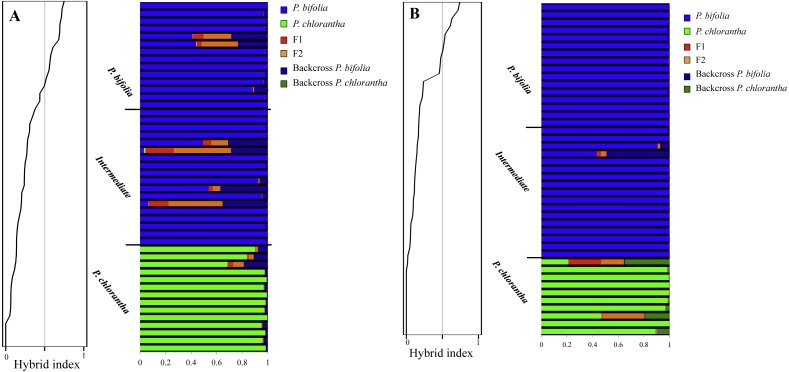
Hybrid Index of sympatric populations (A: Botton; B: Bois Niau) and Bayesian inference of genotype class estimated with NEWHYBRIDS.Hybrid Index of sympatric populations is showed on the left (A: Botton; B: Bois Niau). On the right, Bayesian inference of genotype class estimated with NEWHYBRIDS. Colors represent the genotype classes and individuals are represented as rows. Within each row the extent of the component colors show the posterior probability of an individual with respect to each genotype class and the a priori group assignment is also displayed.